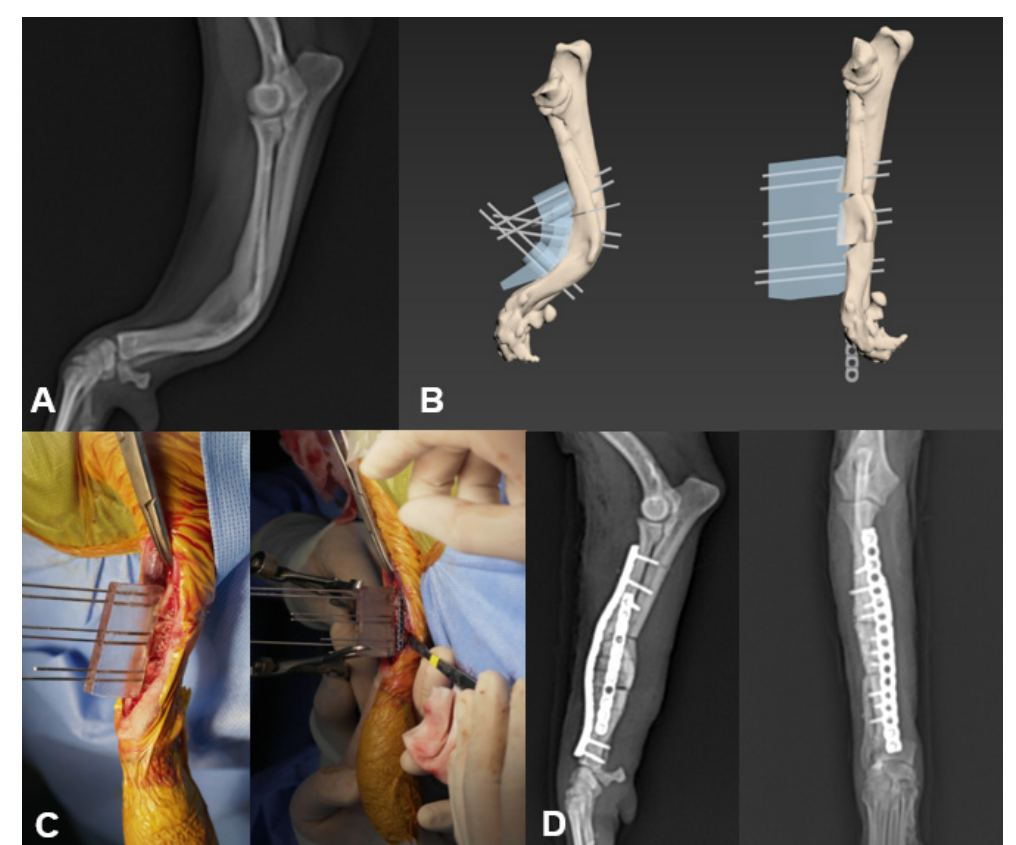
Figure 1. The application of patient-specific guides in case 1. Preoperative mediolateral radio-ulnar projection ( A ). Rehearsal surgery in 3D computer software with osteotomy guide and reduction guide ( B ). K-wires were accurately inserted in the canal of a patient-specific guide (PSG) connected with the bone before osteotomy, and the segments of bone were translated and rotated to an optimal position with the reduction guide. Intraoperative application of PSG ( C ). Plates were precontoured on the plan to avoid K-wires. Immediate postoperative mediolateral and craniocaudal radiographs of the affected limb ( D ). PSGs, patient-specific guides.